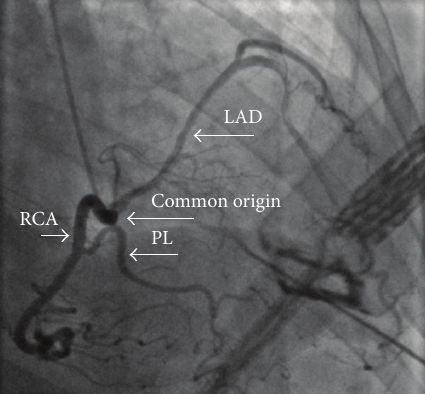
Figure 3: Coronary angiogram showing clear coronaries and anom- alous left anterior descending artery originating from the right coro- nary cusp. RCA: right coronary artery; LAD: left anterior descend- ing artery; PL: posterolateral